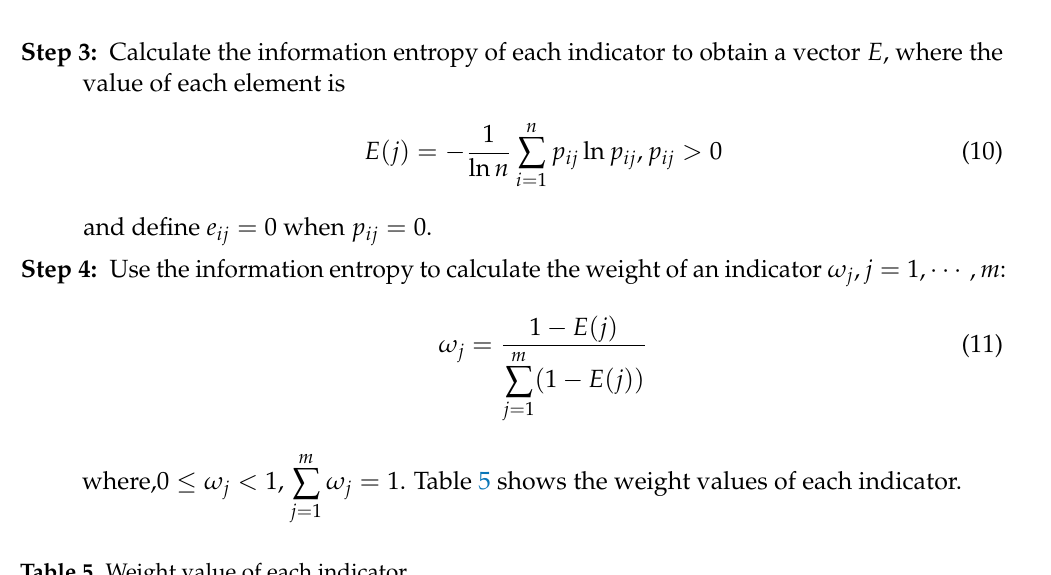
Table 5. Weight value of each